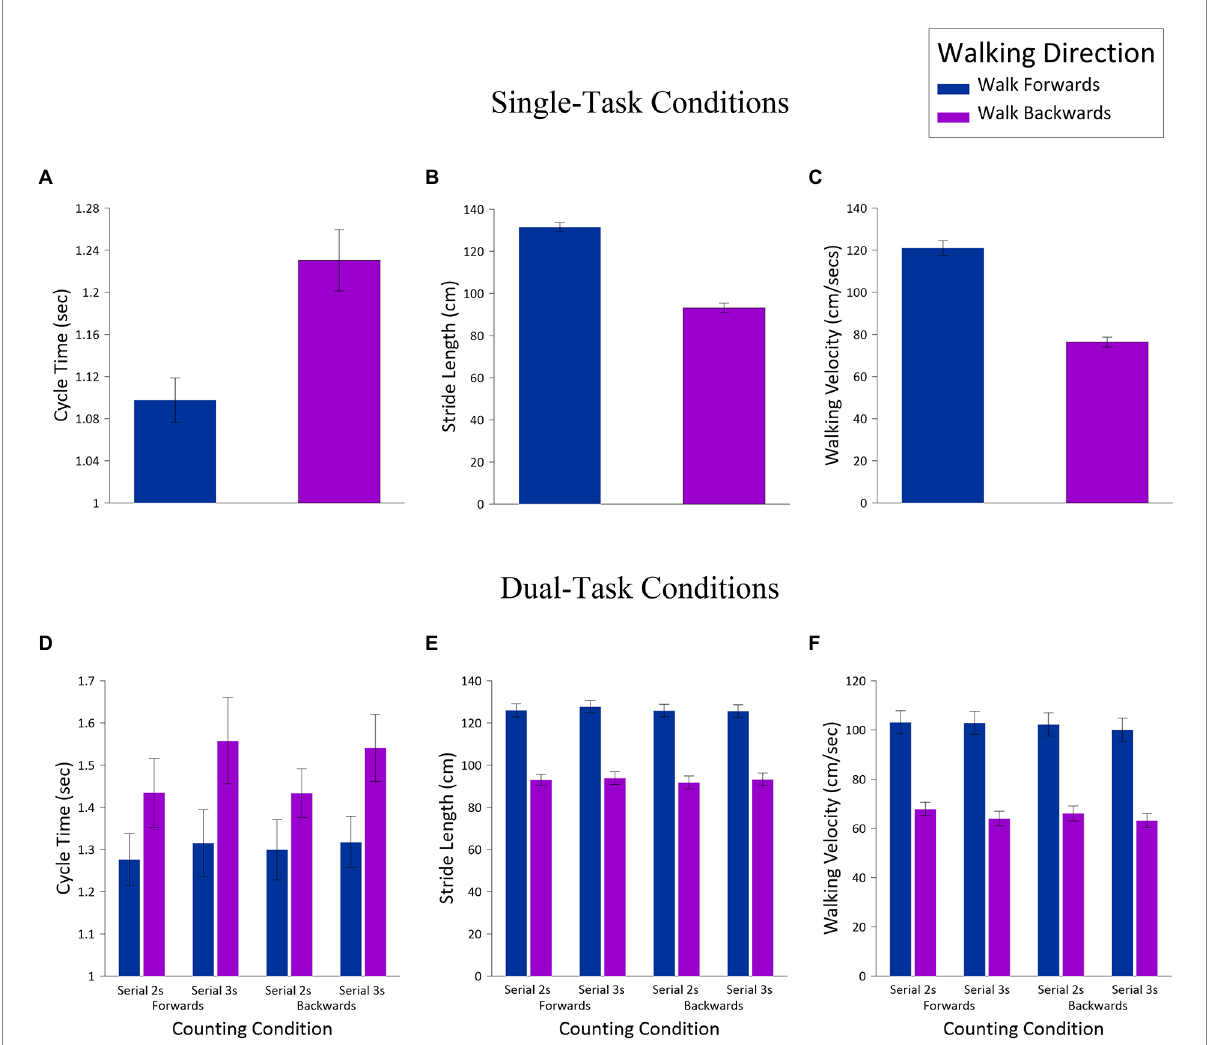
FIGURE 1 Single-task motor performance (kinematic) measures [cycle time ( A ), stride length ( B ), and walking velocity ( C ) and dual-task measures cycle time ( D ), stride length ( E ), and walking velocity ( F )], as a function Walking Direction (walk forward, walk backward), Counting Direction (count forward, count backward), and Counting Difficulty (serial 2 s, serial 3